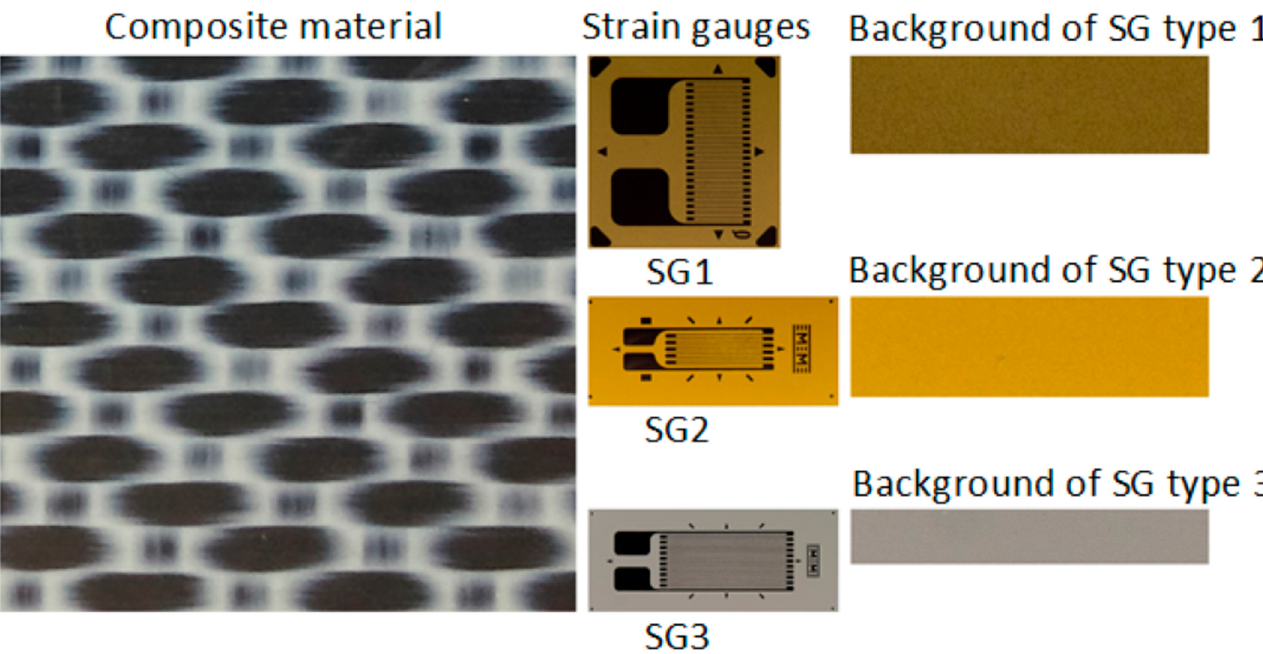
Figure 1. Sample of initial images.